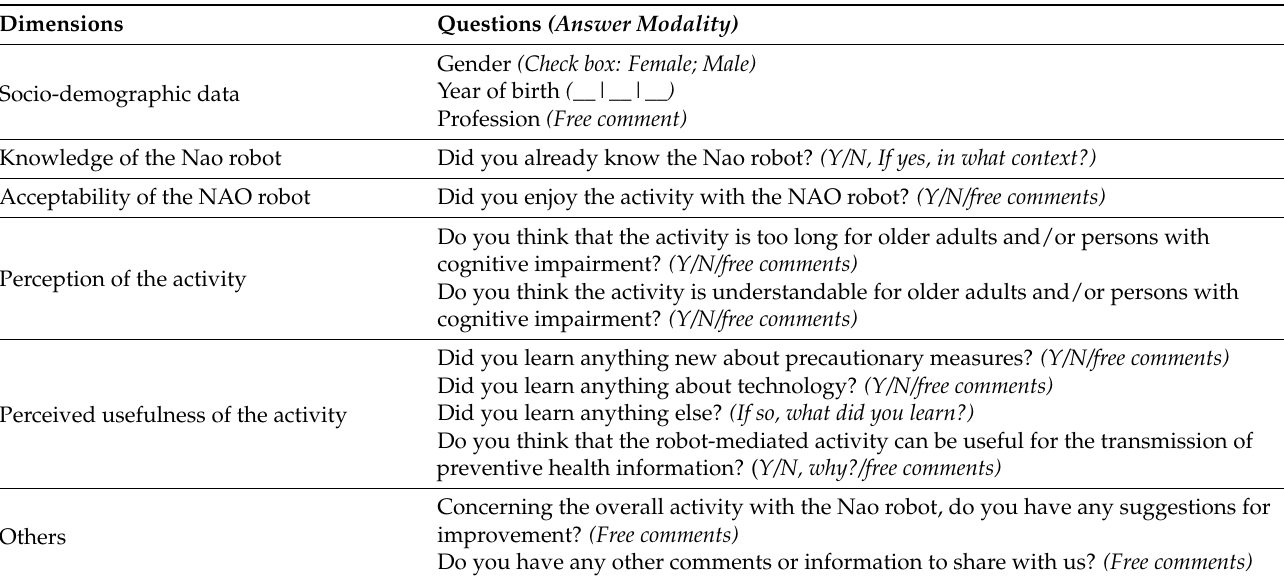
Table 2. Dimensions and related issues addressed in the questionnaire for hospital